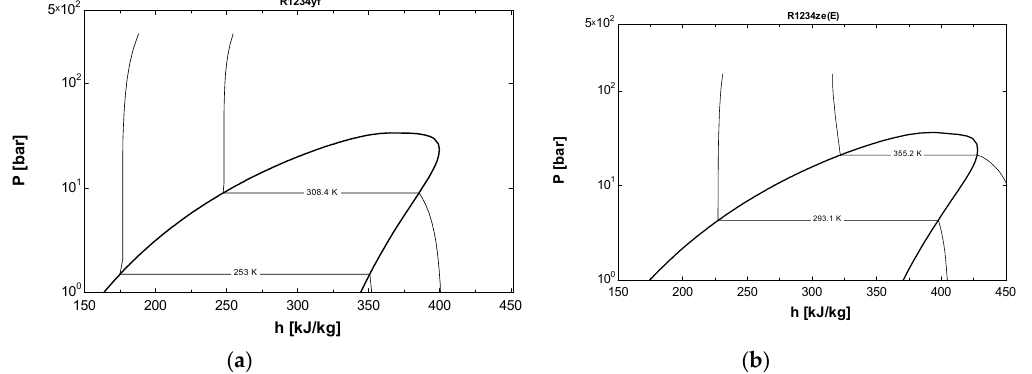
Figure 5. Comparison of VCRC on a p–h plot for ( a ) R1234yf and ( b ) R1234ze(Z).